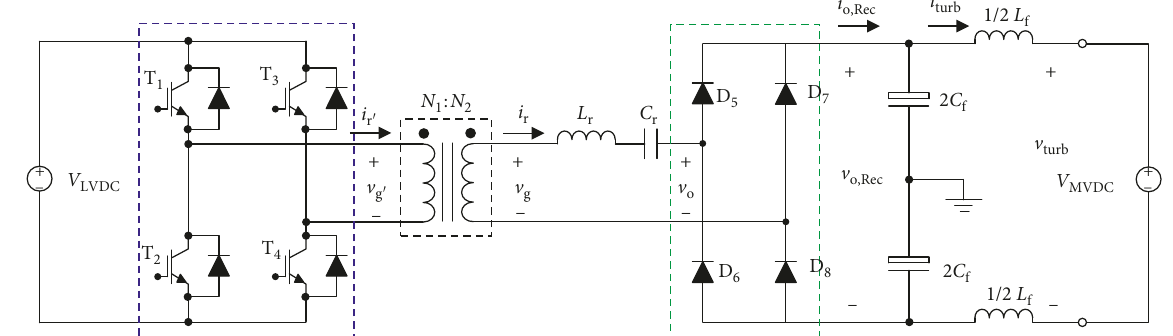
Figure 3: Circuit topology of the DC wind turbine converter